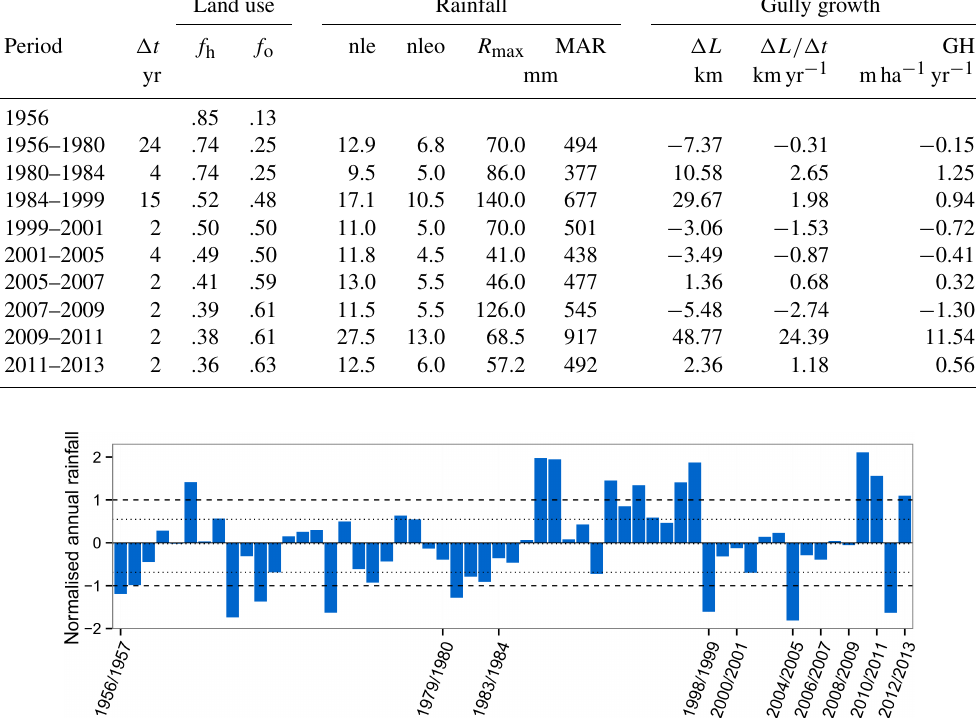
Figure 6. Standardized annual rainfall in the period